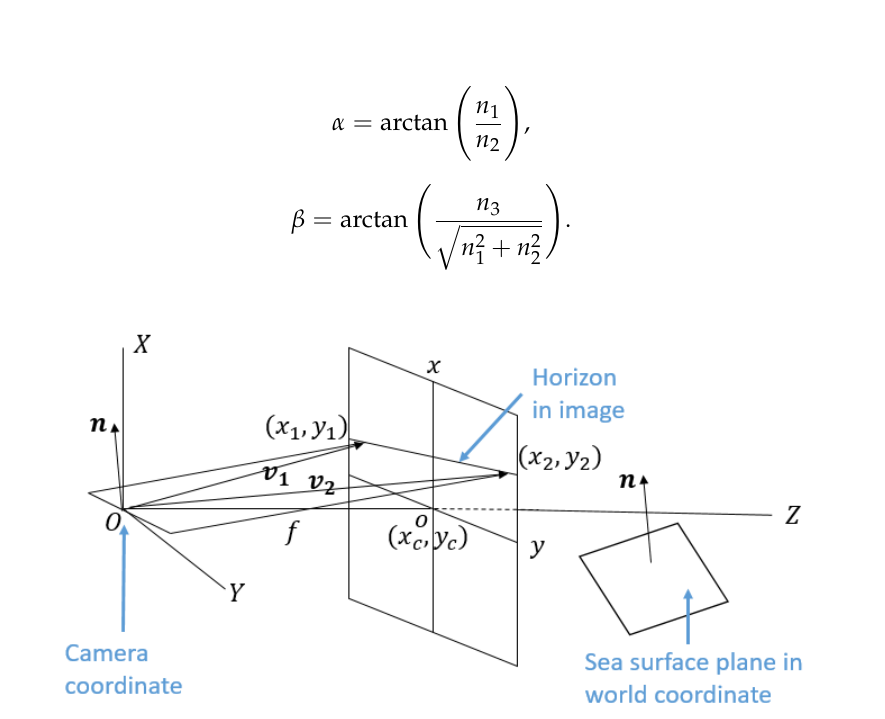
Figure 4. Sea surface plane estimation from the horizon line.